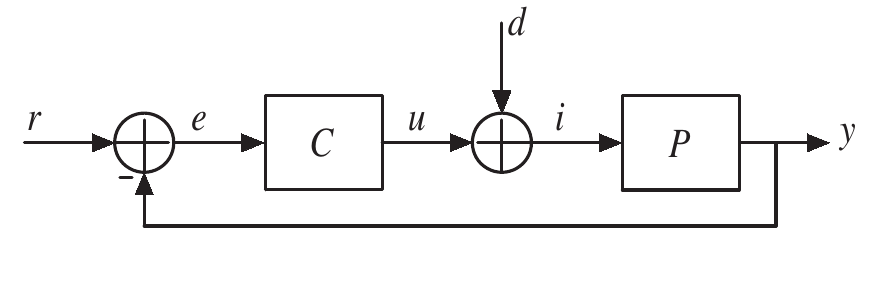
Figure 1. The control scheme